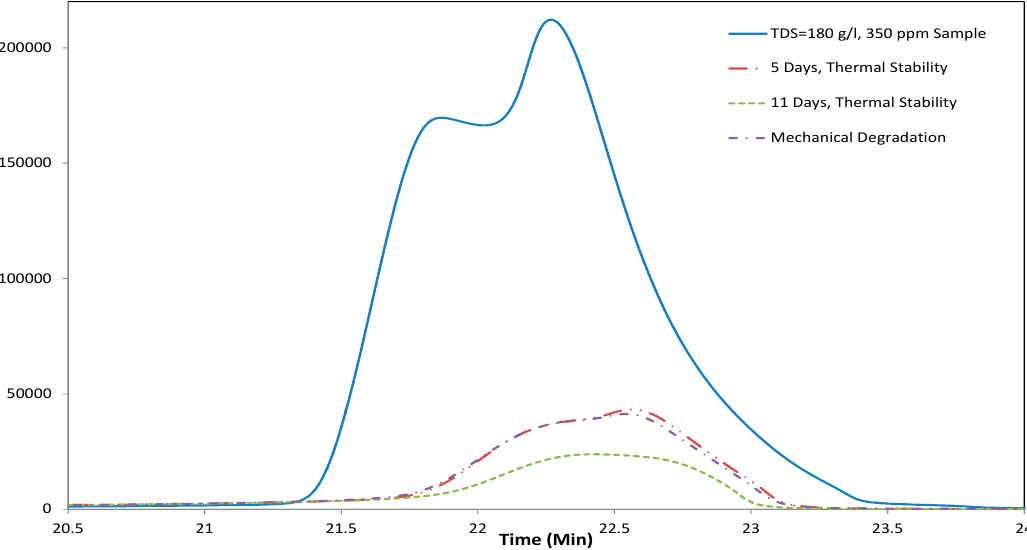
Figure 9. Molecular weight distribution of the biopolymer solutions made with the 180 g / L brine (SAMA).